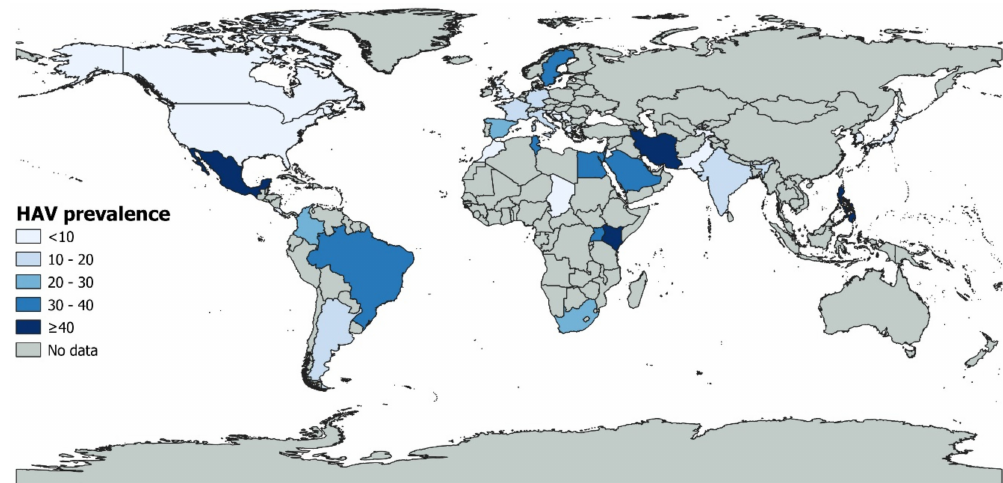
Figure 3. Global HAV